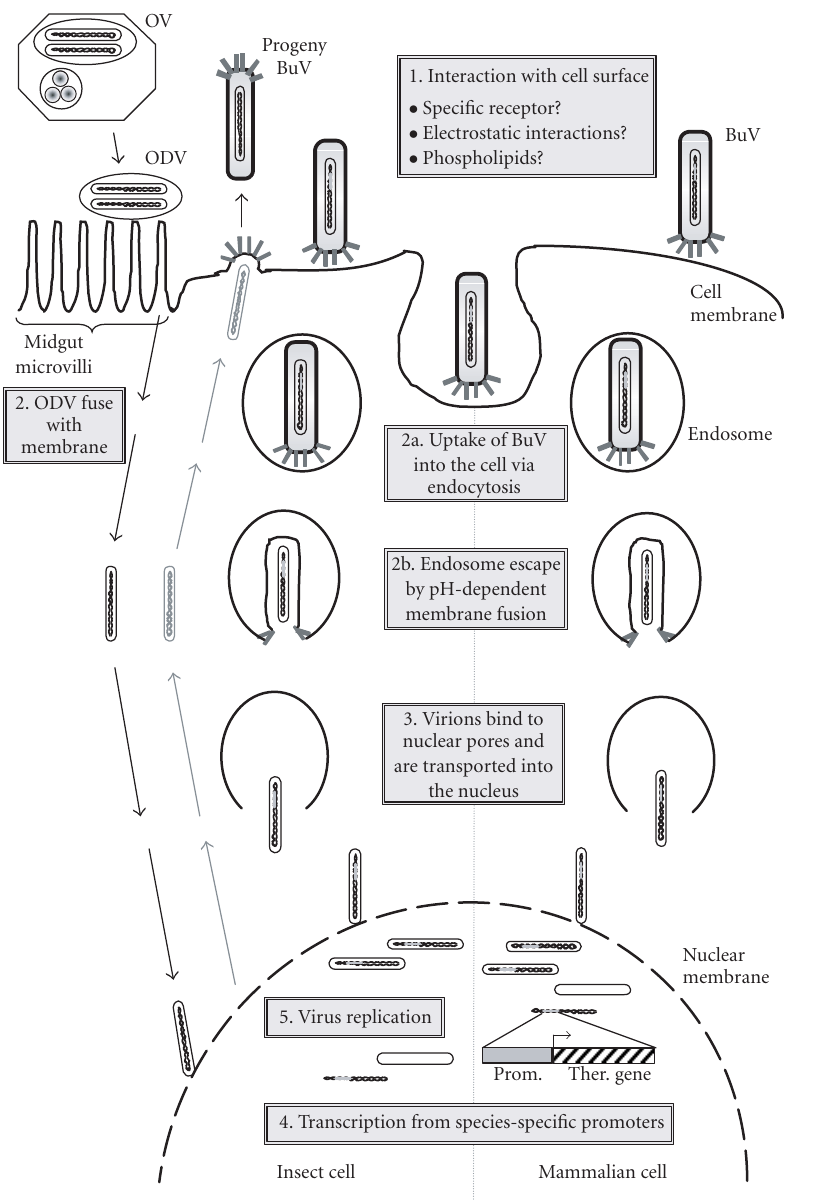
Figure 1. Baculovirus infection of insect and mammalian cells. (1) Budded virus (BuV) particles interact with the mammalian cell surface via the surface gp64 protein in both insect and mammalian cells (described in the text). The occluded virus (OV) polyhedrin matrix is digested in the insect midgut lumen releasing occlusion derived virions (ODV), which consist of multiple nucleocapsids surrounded by a membrane. (2) ODV particles fuse with the microvilli membranes of midgut epithelial cells, releasing nucleocapsids into the cytoplasm. (2a) BuV particles are taken up into endosomes from which they escape by endosome acidification and membrane fusion (2b). (3) Virus particles are transported to the nucleus where they bind the nuclear pores and whole virions containing the genome are actively transported through the pores into the nucleus. Viral DNA is released from the nucleocapsid. (4) In insect cells, the baculoviral genes are transcribed whereas in mammalian cells, only genes under the control of a mammalian promoter are transcribed. (5) In insect cells, viral DNA is replicated and packaged into nucleocapsids. During the late phase of infection, nucleocapsids exit the nucleus and bud from the cell membrane to form BuV. During the very late stage of infection, nucleocapsids remain in the nucleus where they are enveloped and embedded in a polyhedrin matrix to produce OV. In mammalian cells, virus replication does not take place and no progeny virus is